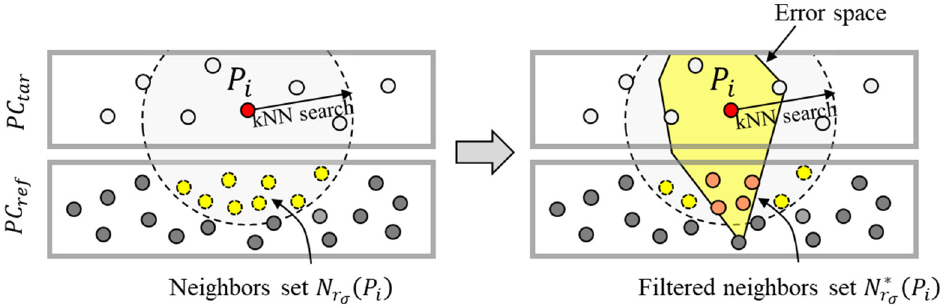
Figure 5. Neighboring point search and filtering.